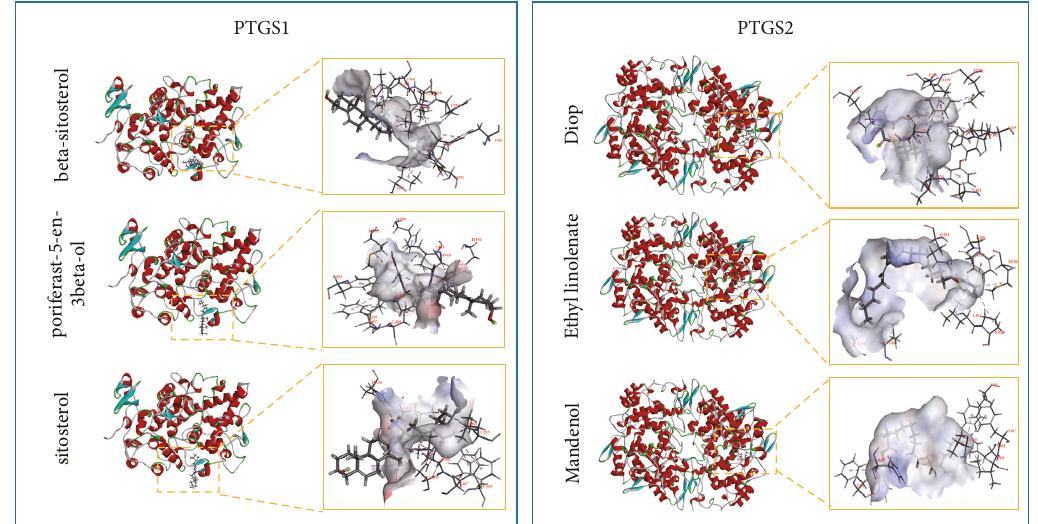
Figure 8: The 3D interaction diagrams of active drug components and the PTGS1 and PTGS2